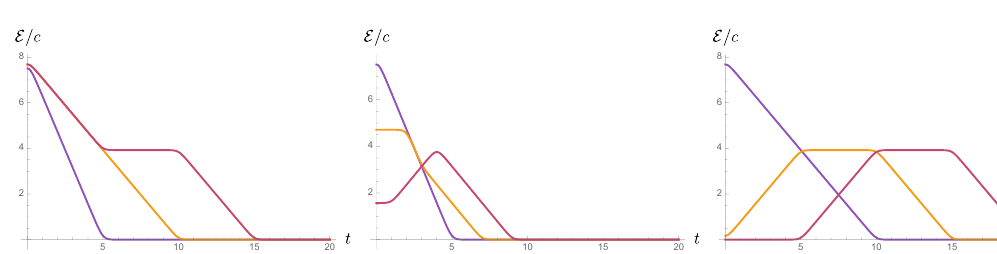
Figure 4 . The universal contribution to the negativity (3.14). (left) OLN with l 1 = 5, l 2 = 5 (purple), 10 (yellow), 15 (magenta), and both intervals starting at the same position. (center) OLN with l 1 = l 2 = 5, and the distance between starting positions varying as 0 (purple), 2 (yellow), 4 (magenta). (right). OLN with l 1 = 5, l 2 = 10, fully overlapped (purple), adjacent (yellow), and separated by 5 (magenta). We take (cid:12) = 2. It is clear that the qualitative behavior of the negativity follows the quasi-particle